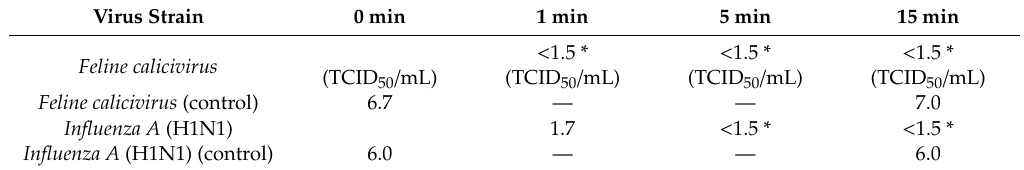
Table 2. Assay of the activity of BiSCaO Water against an enveloped virus and a nonenveloped virus. Virus Strain 0